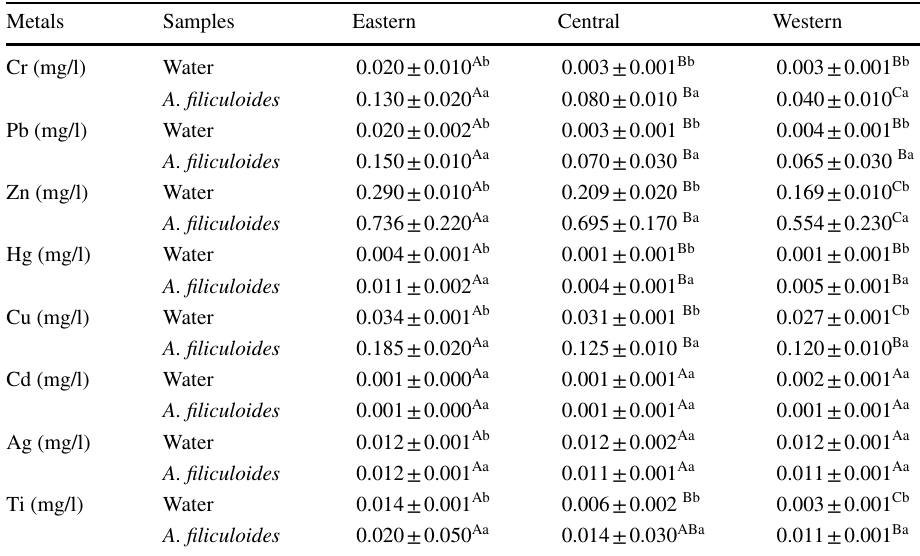
Table 1 Concentration of heavy metals (Cr, Pb, Zn, Hg, Cu, Cd, Ag, Ti) (mean ± standard deviation) in water and A. filiculoides samples (mg/l) in the eastern, central and western parts of the Anzali wetland.